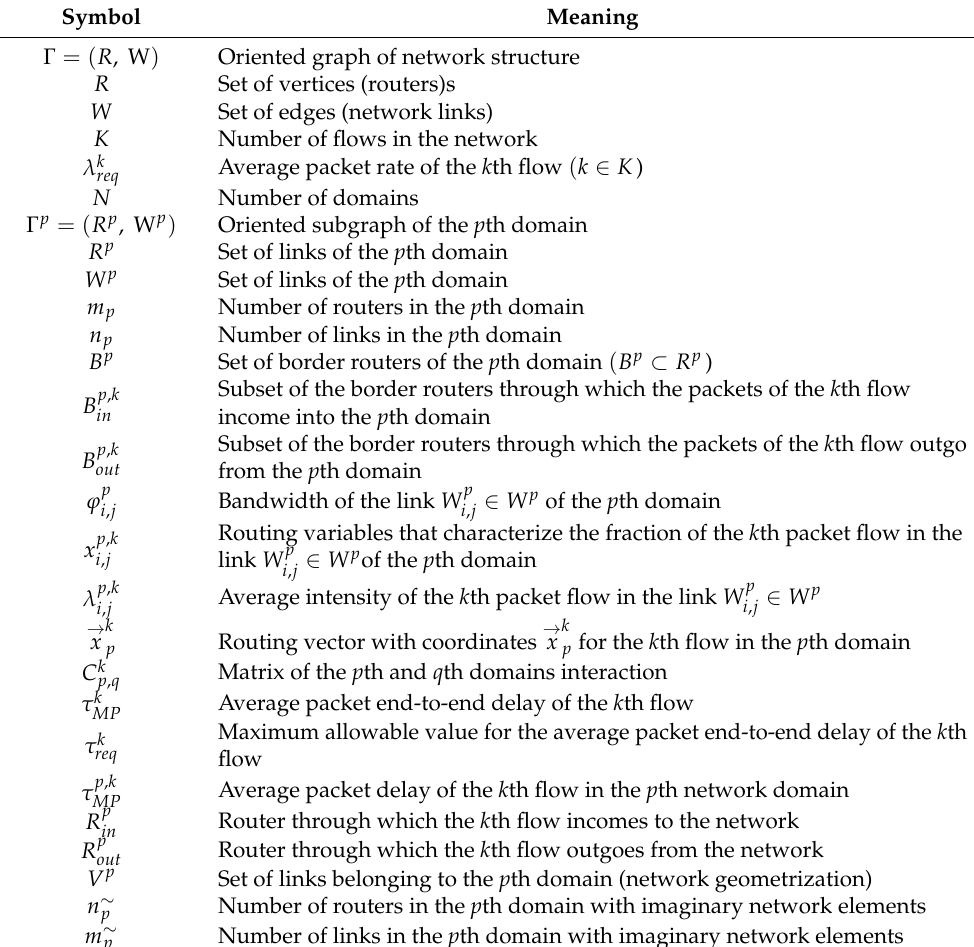
Table 2. Notation